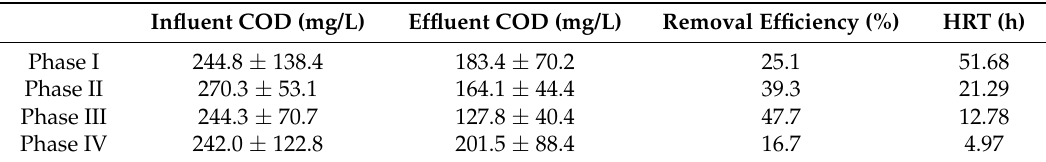
Table 1. COD removal during different stages of